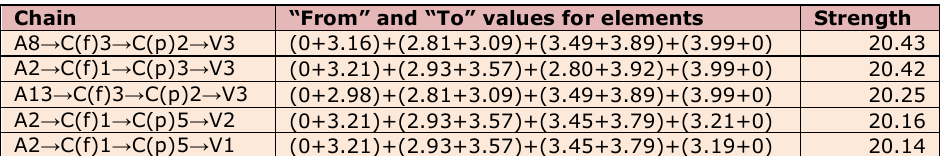
Figure 5. Hierarchical Value Map for electronic tour guide design Chain “From” and “To” values for elements